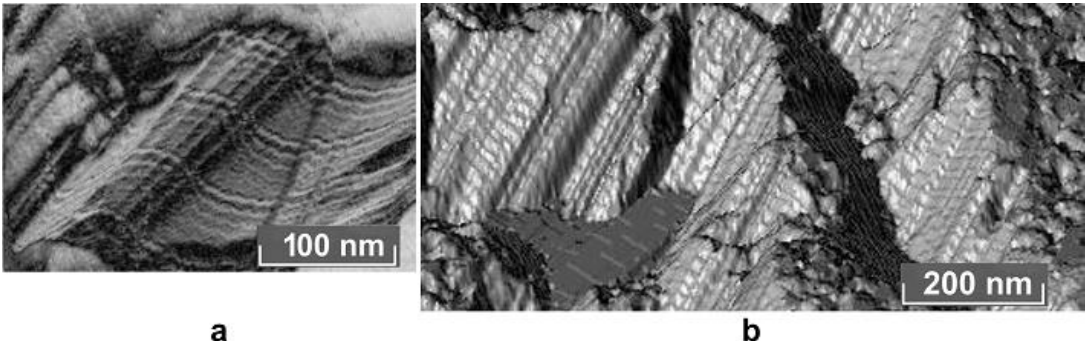
Figure 5. An image of a RDS in an LiNbO 3 :Gd (0.44 wt.%.) crystal. Obtained using an atomic force microscope Nano-R. The figure is reproduced with the permission of Pleiades Publishing, Ltd. from